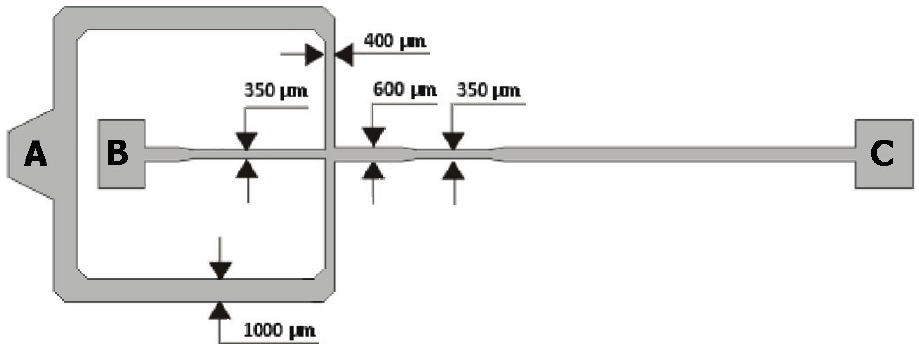
Figure 1. Schematic diagram of the microchannel geometry with a diverging and converging bifurcation where the width of channels A and C are 300, 500, or 1000 μ m, and the widths of respective ramifications B are 150, 250, or 500 μ m.